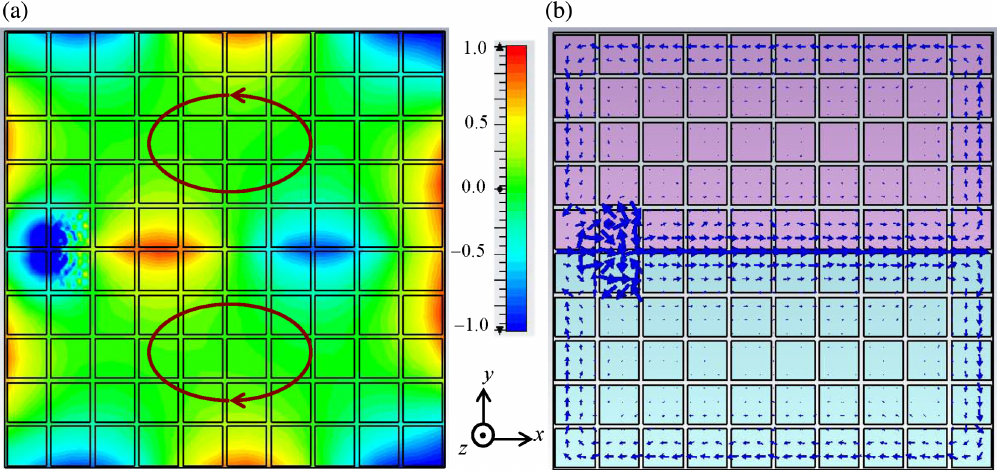
FIG. 4. Photonic crystal cavity terminated with PEC lateral walls. The region y > 0 (top half of the cavity) is biased with a positive 0 . 8 ω (along þ z ) magnetic field ( ω ), and the region y < 0 (bottom half of the cavity) with a negative (along − z ) magnetic field c ¼ þ p − 0 . 8 ω ( ω ). The cavity is excited with a vertical (along þ y ) short electric dipole placed at the interface of the two regions near the c ¼ p left-hand side lateral wall. The oscillation frequency of the dipole is ω ¼ 0 . 5 ω (b) Poynting vector lines showing how the energy circulates in the